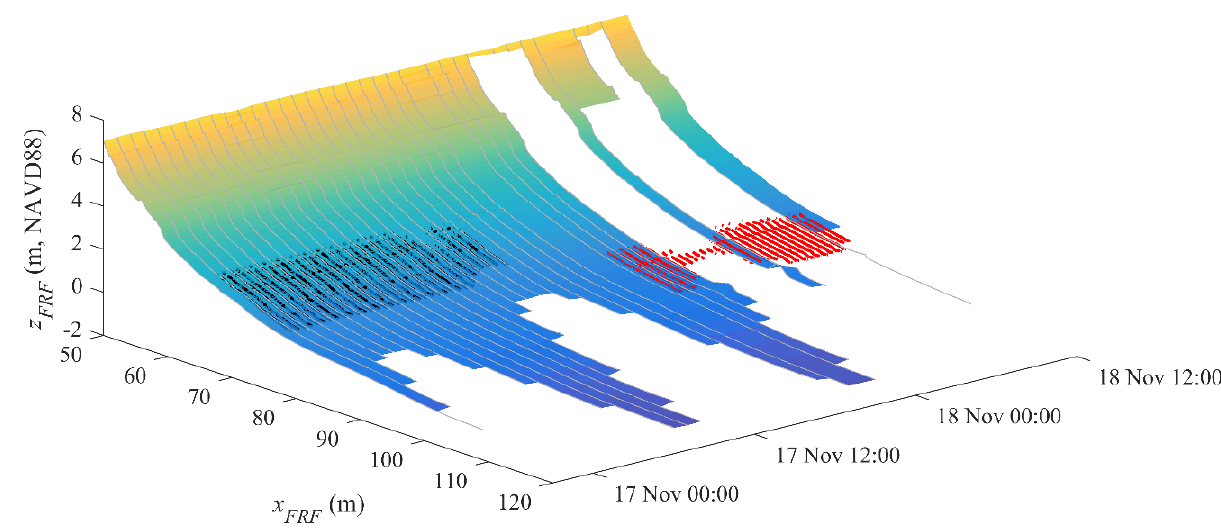
Figure 7. Time stack of half-hourly (hourly), time-averaged beach profiles measured by the LLC LiDAR (FRF DUNE LiDAR) for Series B (black) and Series C (red). The gray lines and colored surface are the FRF DUNE LiDAR hourly profiles. The thick black (red) lines running parallel to the time axis indicate the location of the LLC LiDAR puck for Series B (Series C).Times in UTC.